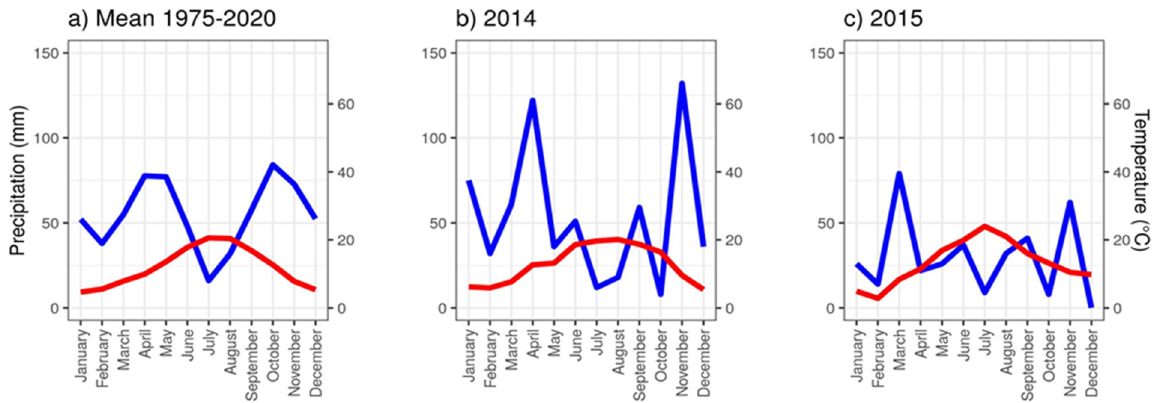
Figure 1. Bagnouls-Gaussen ombrotermic diagram of mean climatic temperature (in red) and precipitation (in blue) by month in the study site. ( a ) Mean monthly data from 1975 to 2020. ( b ) Mean monthly data for 2014. ( c ) Mean monthly data for 2015.